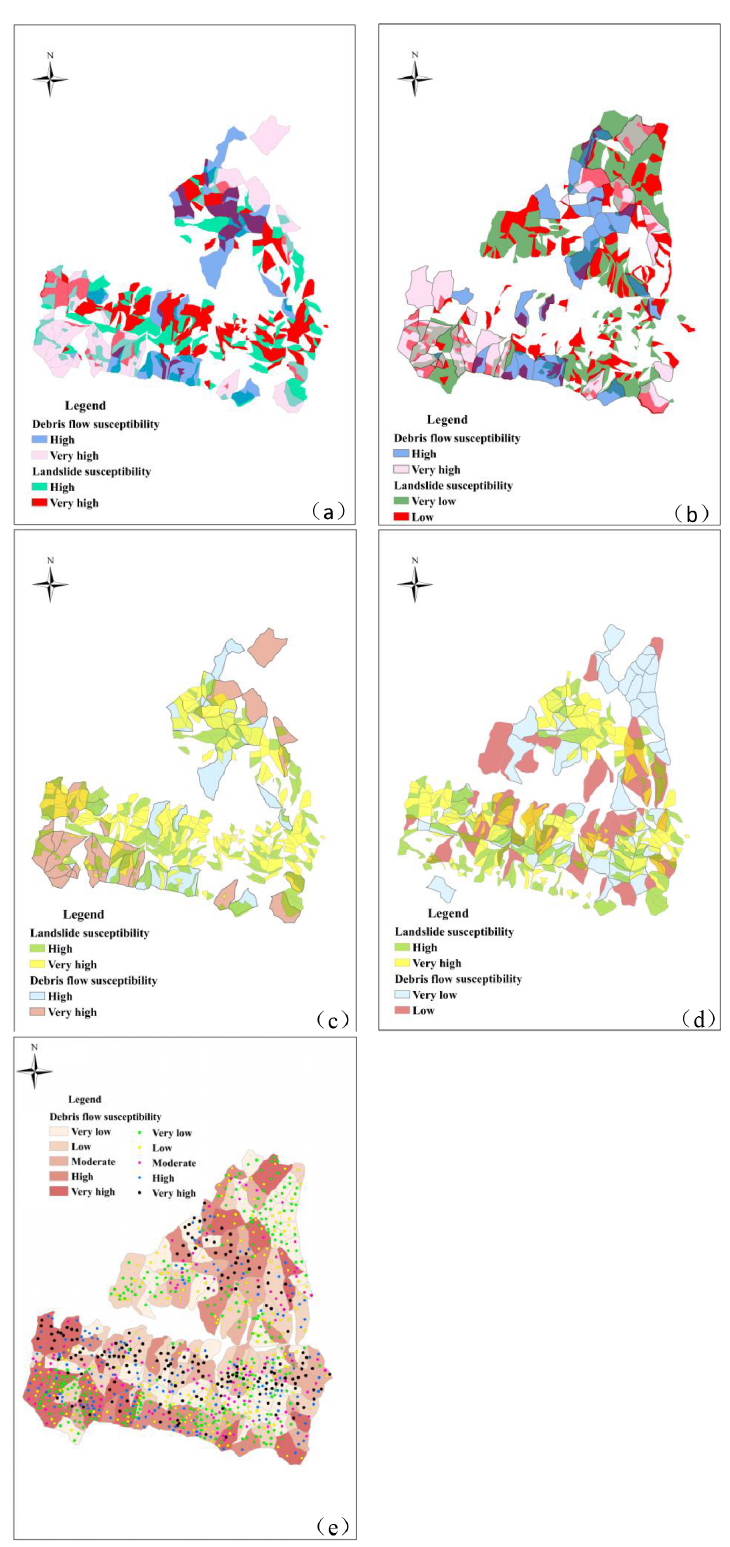
Figure 11. Landslide–debris-flow susceptibility maps: (a) high- and very-high-class watershed units with high- or very-high-class slope units, (b) high- or very-high-class watershed units with low- or very-low-slope units, (c) high- or very-high-class slope units with high- or very-high-class watershed units, and (d) mapping